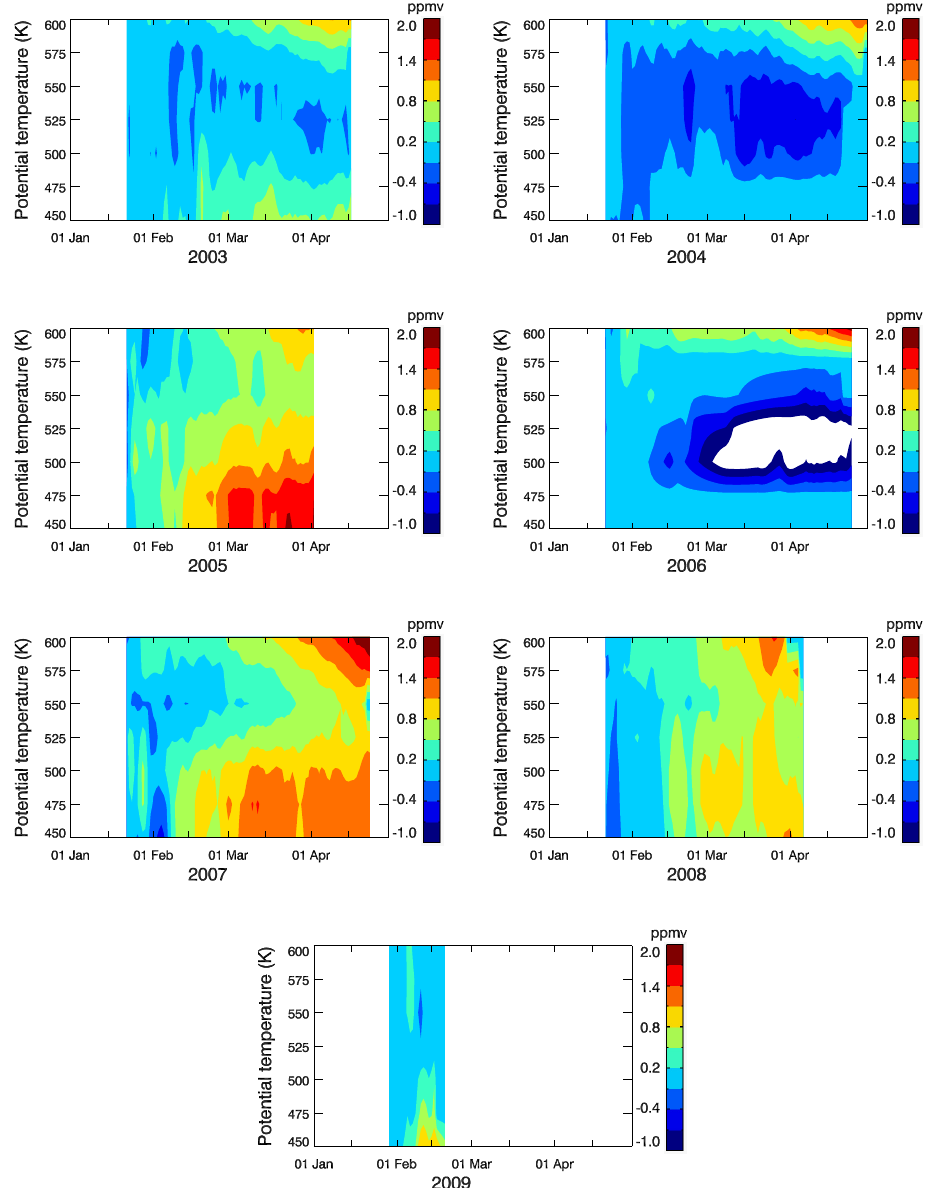
Fig. 5. Derived vortex average ozone losses as a function of time and potential temperature for the winters 2002/2003 to 2008/2009 in the Arctic winter stratosphere. With the exception of 2009 the reference period is January 19 – 25 and the chemical ozone losses are determined starting on January 22 of each year (see Table 1).